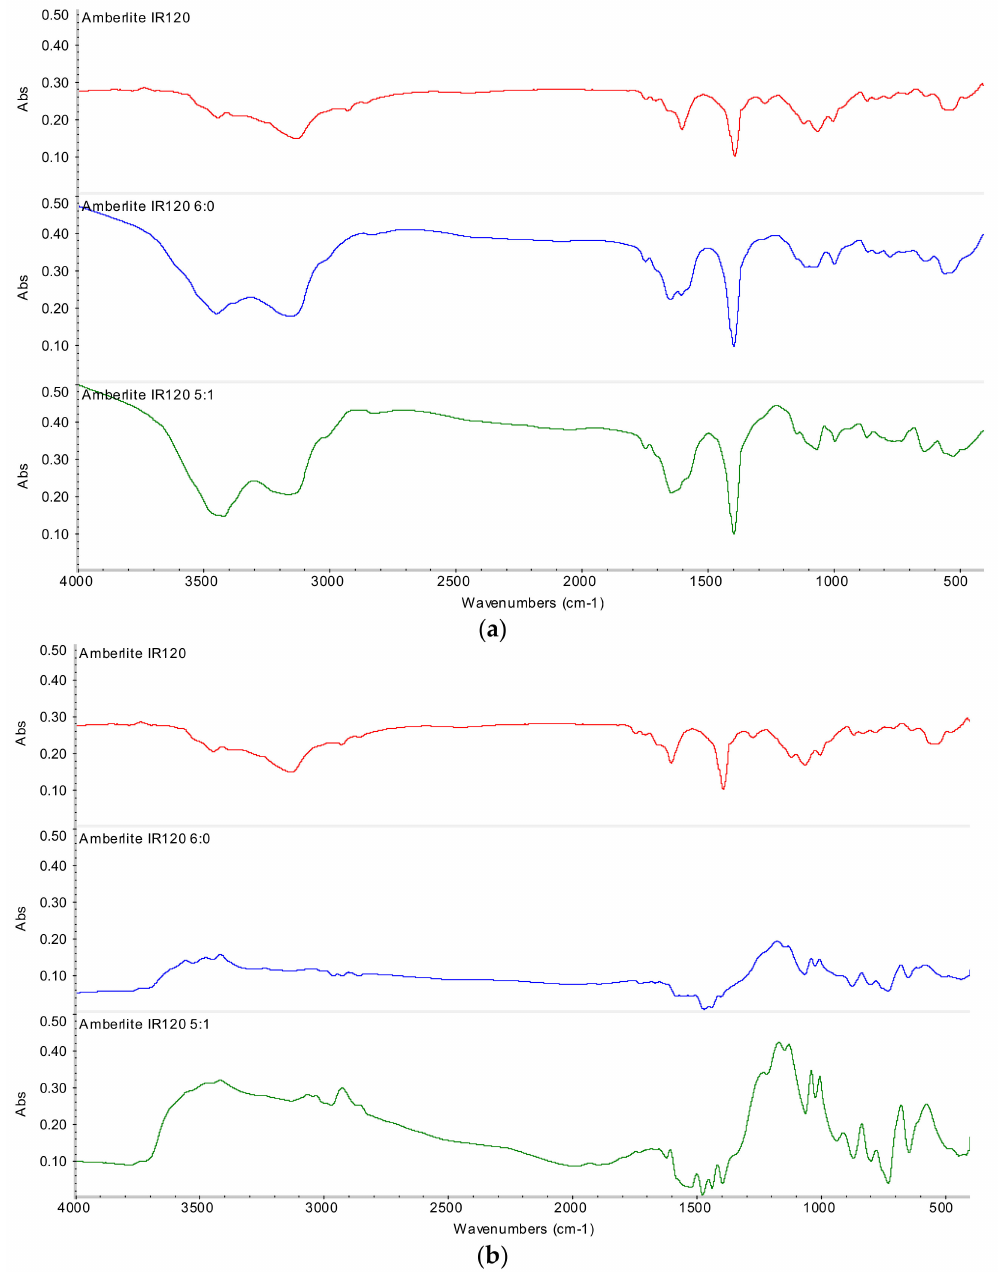
Figure 9. FTIR spectra of ( a ): Amberlite IR120; Amberlite IR120 6:0 (with Nd 3+ ions); Amberlite IR120 5:1 (with Nd 3+ ions) and ( b ) Amberlite IR120; Amberlite IR120 6:0 (with Sc 3+ ions); Amberlite IR120 5:1 (with Sc 3+